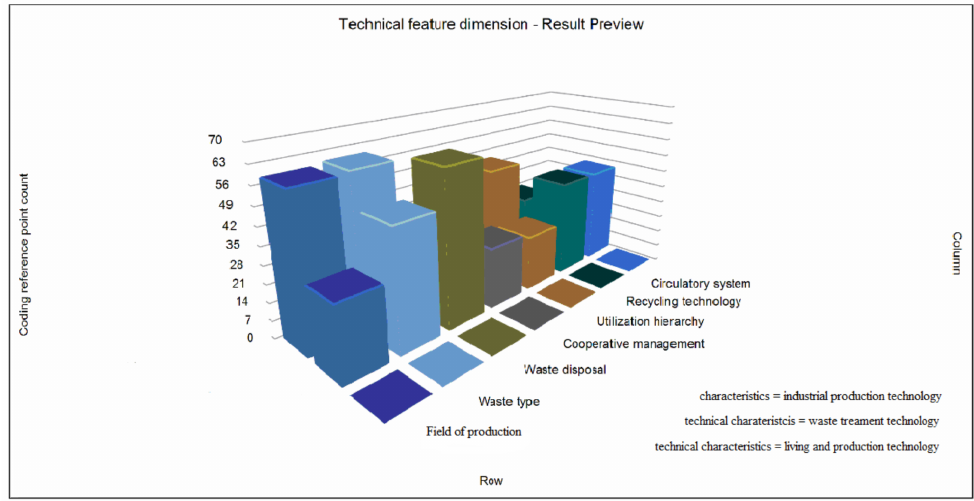
Figure 5. Counting diagram of matrix coding reference points under the dimension of technical